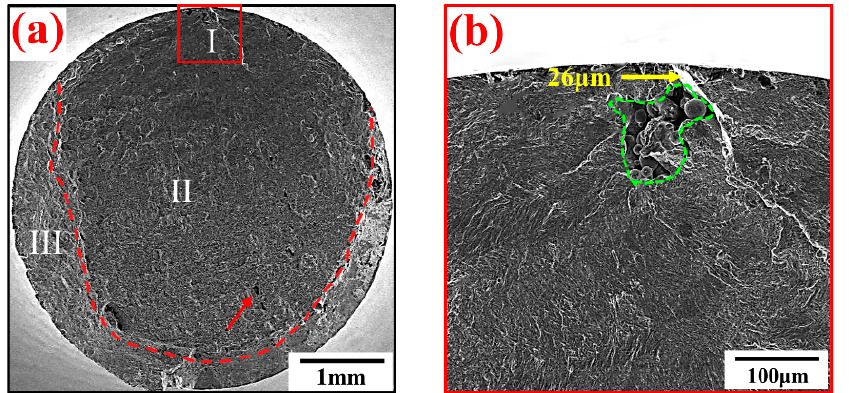
Figure 7. Macroscopic fatigue fracture surface ( a ) and the crack initiation zone ( b ) of the as-built specimen.